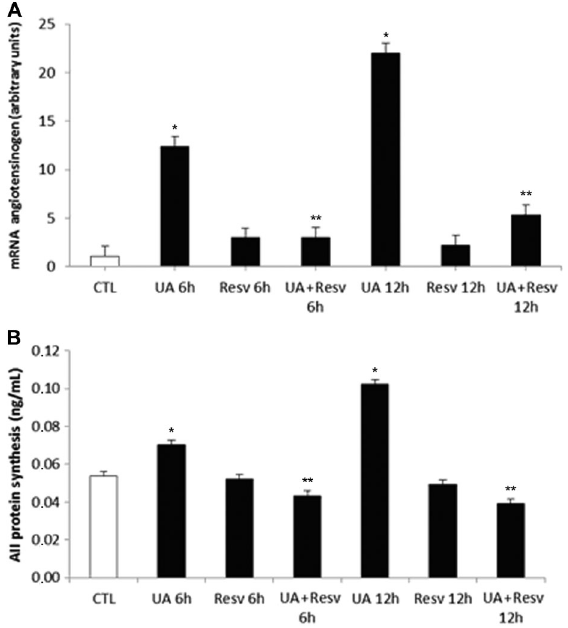
Figure 2. Effect of resveratrol (Resv) treatment on the angiotensinogen mRNA expression ( A ) and AII protein synthesis ( B ) in immortalized human mesangial cells (ihMCs) stimulated with uric acid (UA). Cells were seeded onto plates and after 6 and 12 h were exposed to DMEM with 1% FBS containing 10 mg/dL UA, and 12.5 m M Resv. Data are reported as means±SE. *P , 0.001 vs control (CTL); **P , 0.001 vs UA (Student t -test). lower at both 6 h (0.77±0.18 vs 1.52±0.23 arbitrary units for the UA group) and 12 h (0.41±0.06 vs 2.32±0.18 arbitrary units for the UA group (both P , 0.05, Figure 3A).